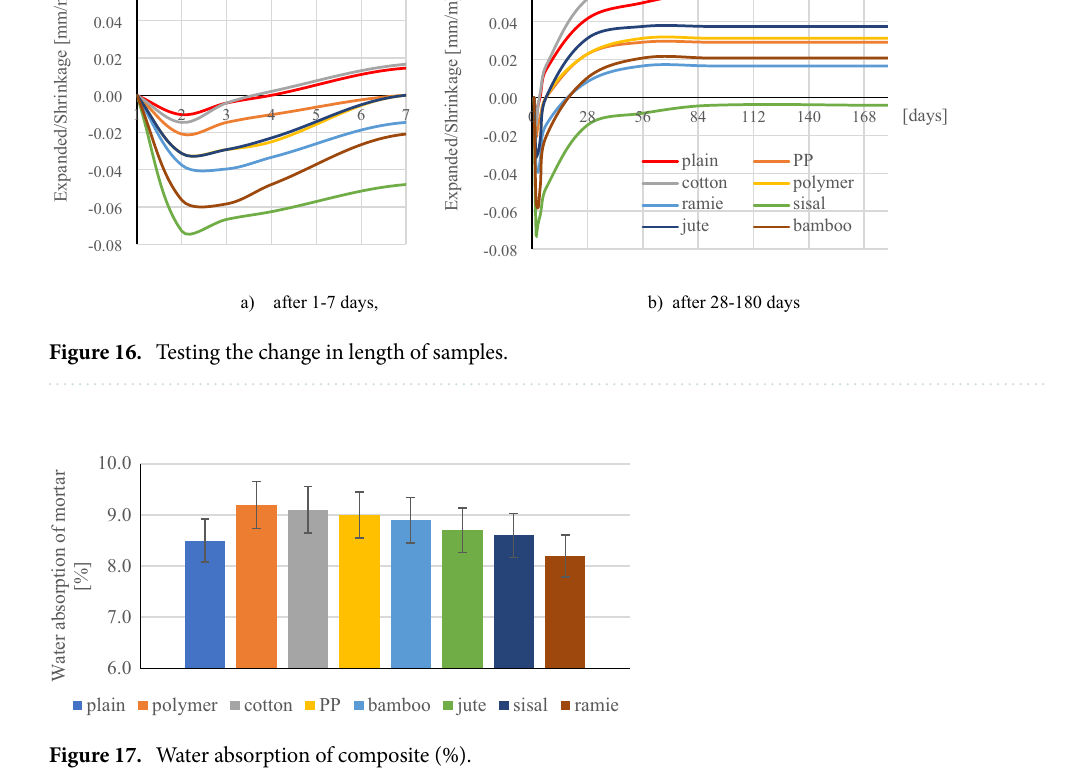
Figure 17. Water absorption of composite